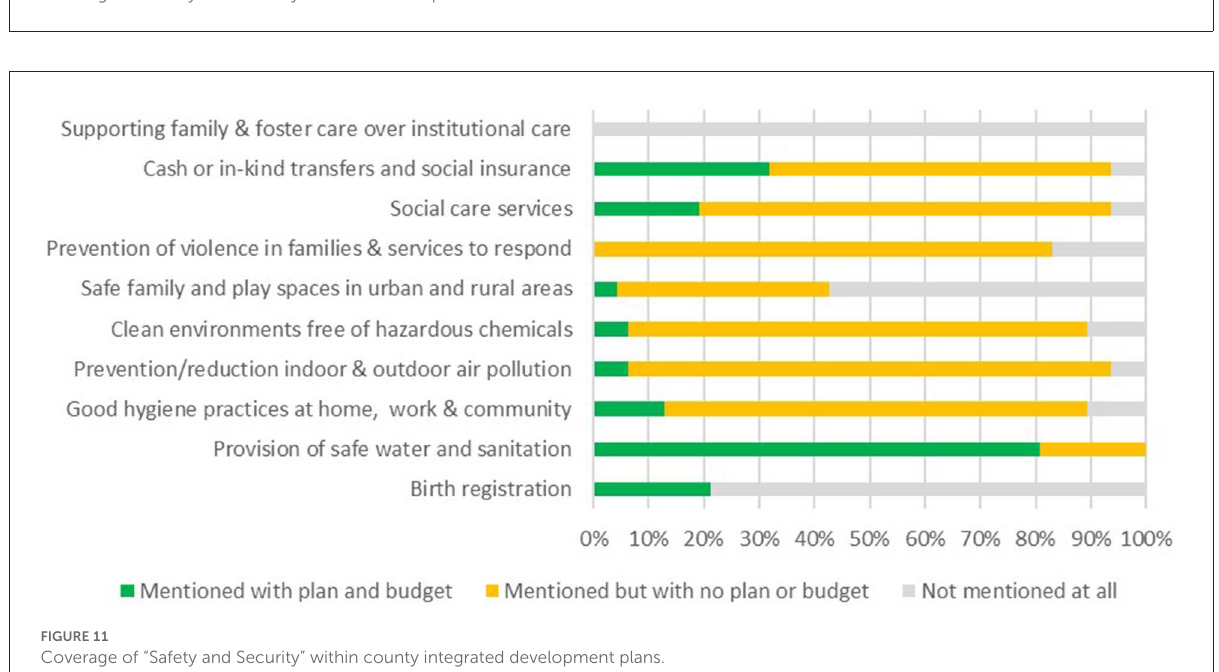
FIGURE10 Coverage of “Safety and Security” within national policies.